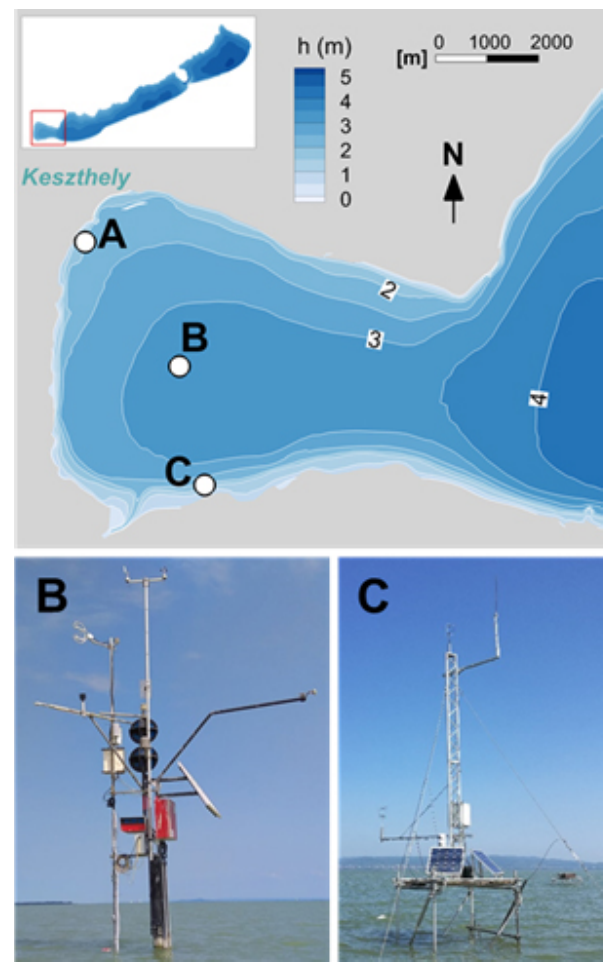
Figure 1. Study site: bathymetry map and station locations. Photos of measurement station B and